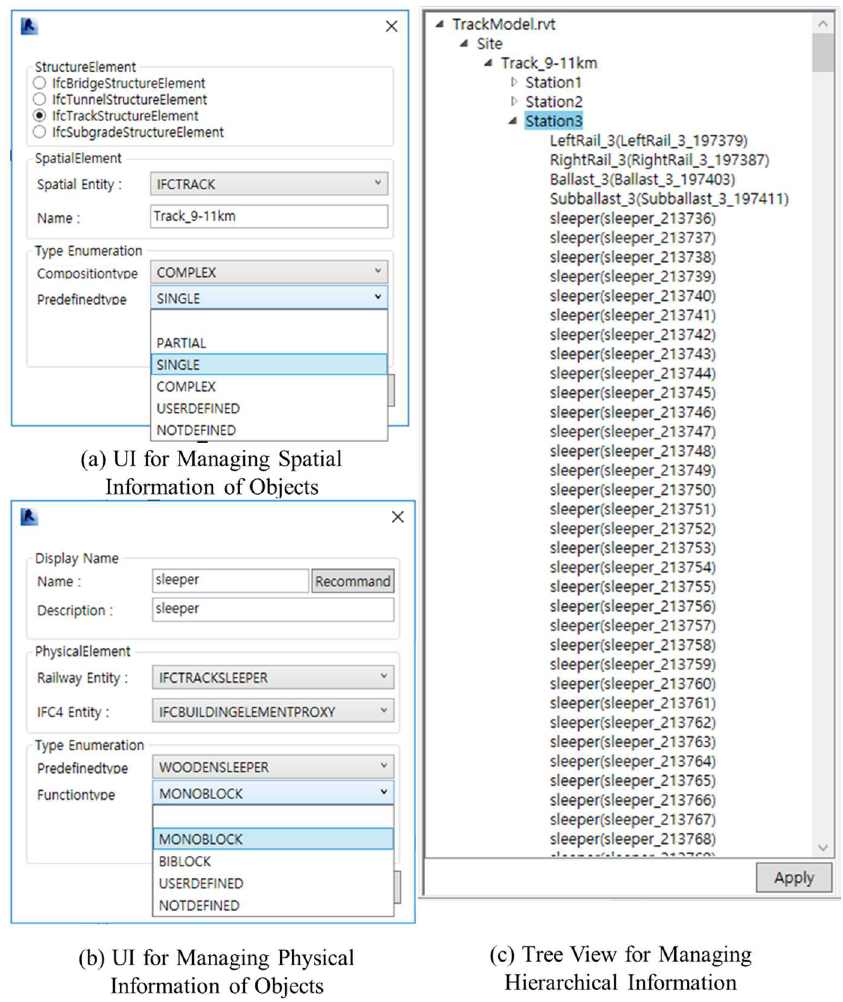
Figure 6. User interfaces for management: ( a ) UI for managing spatial information of each object; ( b ) UI for managing physical information of each object; ( c ) Tree view for managing hierarchical information.